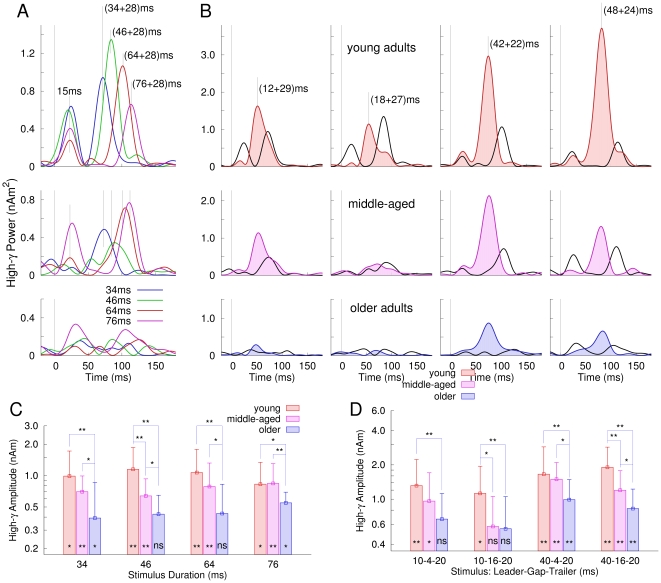
Time courses of activity in the higher gamma band (72–98 Hz) in the right auditory cortex.
A: The responses to the no-gap stimuli exhibit two peaks, the first 15 ms after stimulus onset, the second 28 ms after stimulus offset. The response amplitudes decline with increasing age. B: Time courses of high-gamma responses to gap stimuli are shown in different color for the age groups in comparison to responses to the no-gap stimuli shown as black lines. The main peak in the responses to gap stimuli appears at latency between those of the onset and offset response in the corresponding no-gap stimuli. Responses to gap-stimuli were in general larger than responses to no-gap stimuli (note the different scales on the y-axes). C: Bar graphs representing the peak amplitude of the offset response to no-gap stimuli for the three age groups. The error bars denote the upper 95% confidence limits for the group mean. Results of the analysis of phase coherence across each group are indicated at the base of each bar (*: .05≤p<0.01, **: p≤0.01, ns: not significant). D: Bar graphs of the amplitudes of high-gamma responses to gap stimuli.